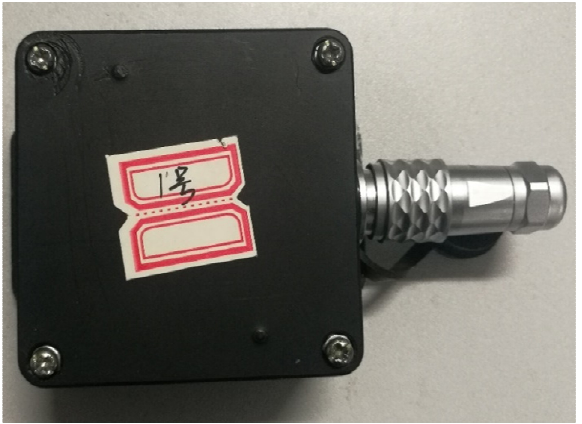
Figure 14. The wireless acceleration sensor.